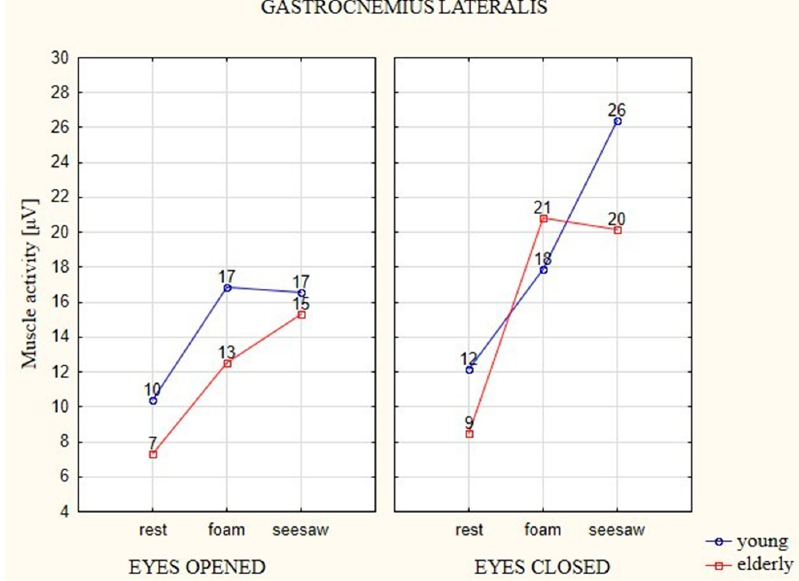
Figure 8. The average EMG values of the GL muscle in elderly and young participants on different types of surfaces and with EO (eyes 1) and EC (eyes 2).